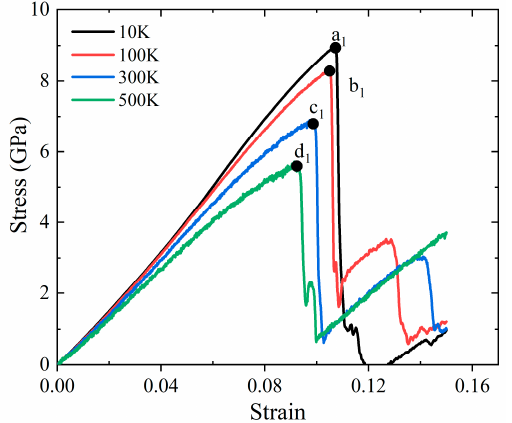
Figure 9. Stress-strain curves for Al-2%Mg alloys under uniaxial tension with different temperature. The four points, a 1 , b 1 , c 1 and d 1 , are the maximum stress at 10 K, 100 K, 300 K and 500 K, respectively.